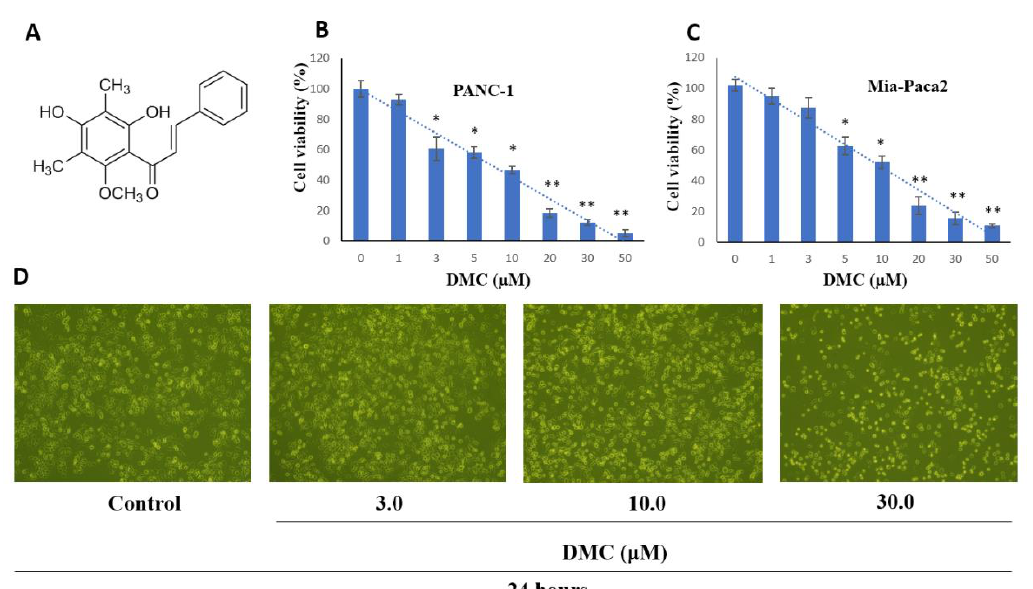
Figure 1. ( A ) Chemical structure of DMC; Effect of DMC on PANC-1 ( B ), and MIA-PACA2 ( C ) cell viability; and ( D ) PANC-1 cell morphology visualized by light microscopy (scale bar 500 µm), cells were seeded into 6-well plates at 1 × 10 5 cells/well and treated with the indicated concentration of DMC for 24 h. Data are presented as the mean ± standard deviation of three independent experiments performed in duplicate (* p < 0.01; ** p < 0.05).